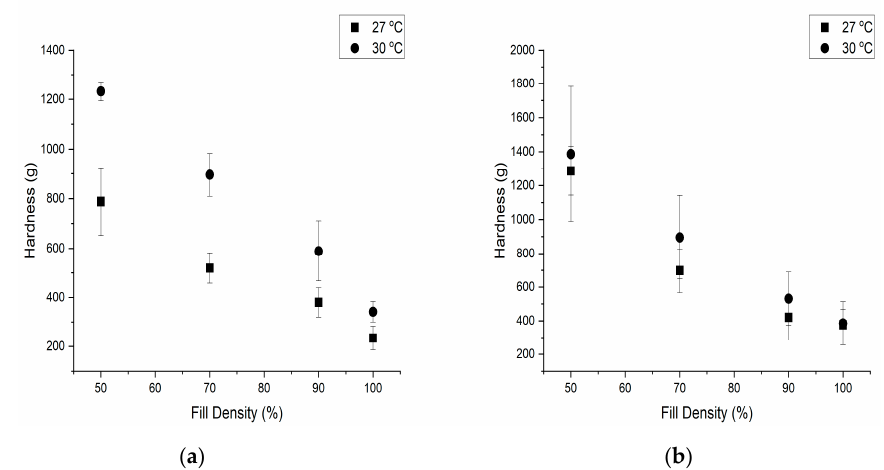
Figure 9. Effect of fill density, temperature, and ( a ) water butter ratio of 3:10. ( b ) Water butter ratio of 6:5 on hardness of baked cookies. Values are mean ± standard deviation ( n = 3).